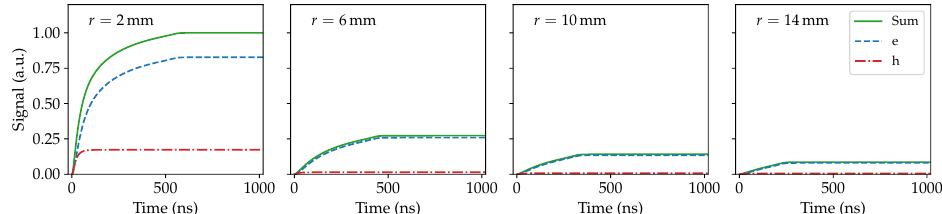
Figure 5. Simulated development of the alpha event signals in the presence of negative charges on the passivated detector surface ( σ = 0.3 10 10 e/cm 2 ) for selected radial positions. Point-like − × charges were started at a depth of z 0 = 16µm. The components from holes (h) and electrons (e) are discussed in the text. The waveforms were simulated using mjd_siggen